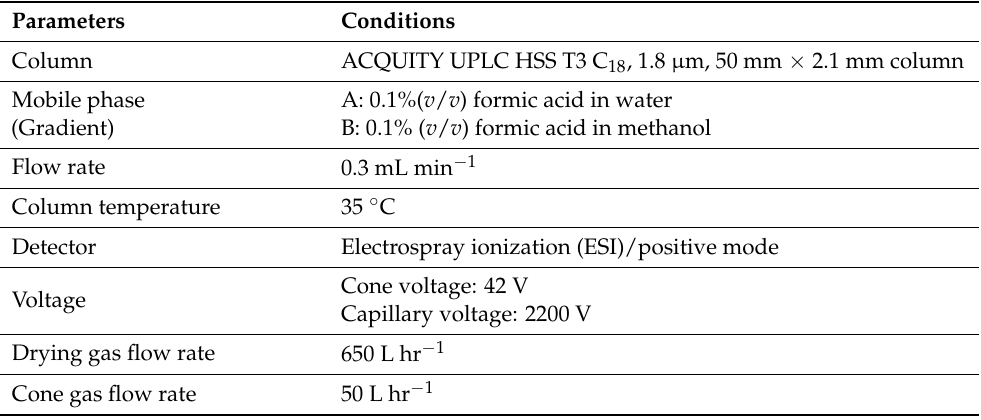
Table 2. The chromatographic conditions for LC/MS/MS method.